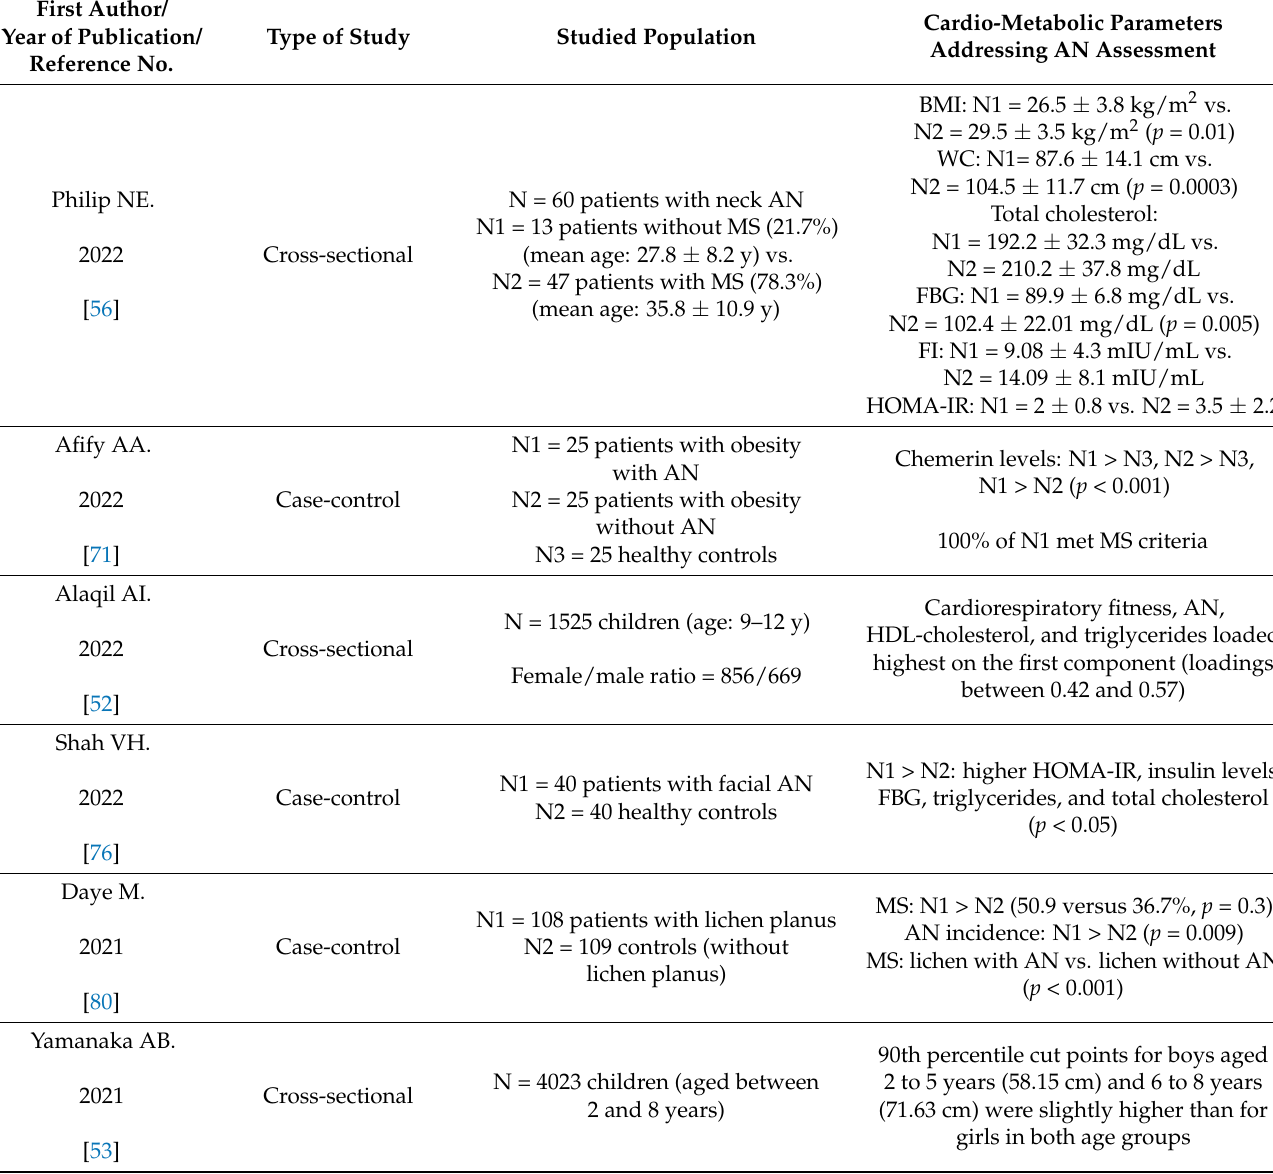
Table 1. Studies within the last 5 years concerning AN and IR in terms of obesity and MS (order of display is from 2022 to 2018) (please see references no.